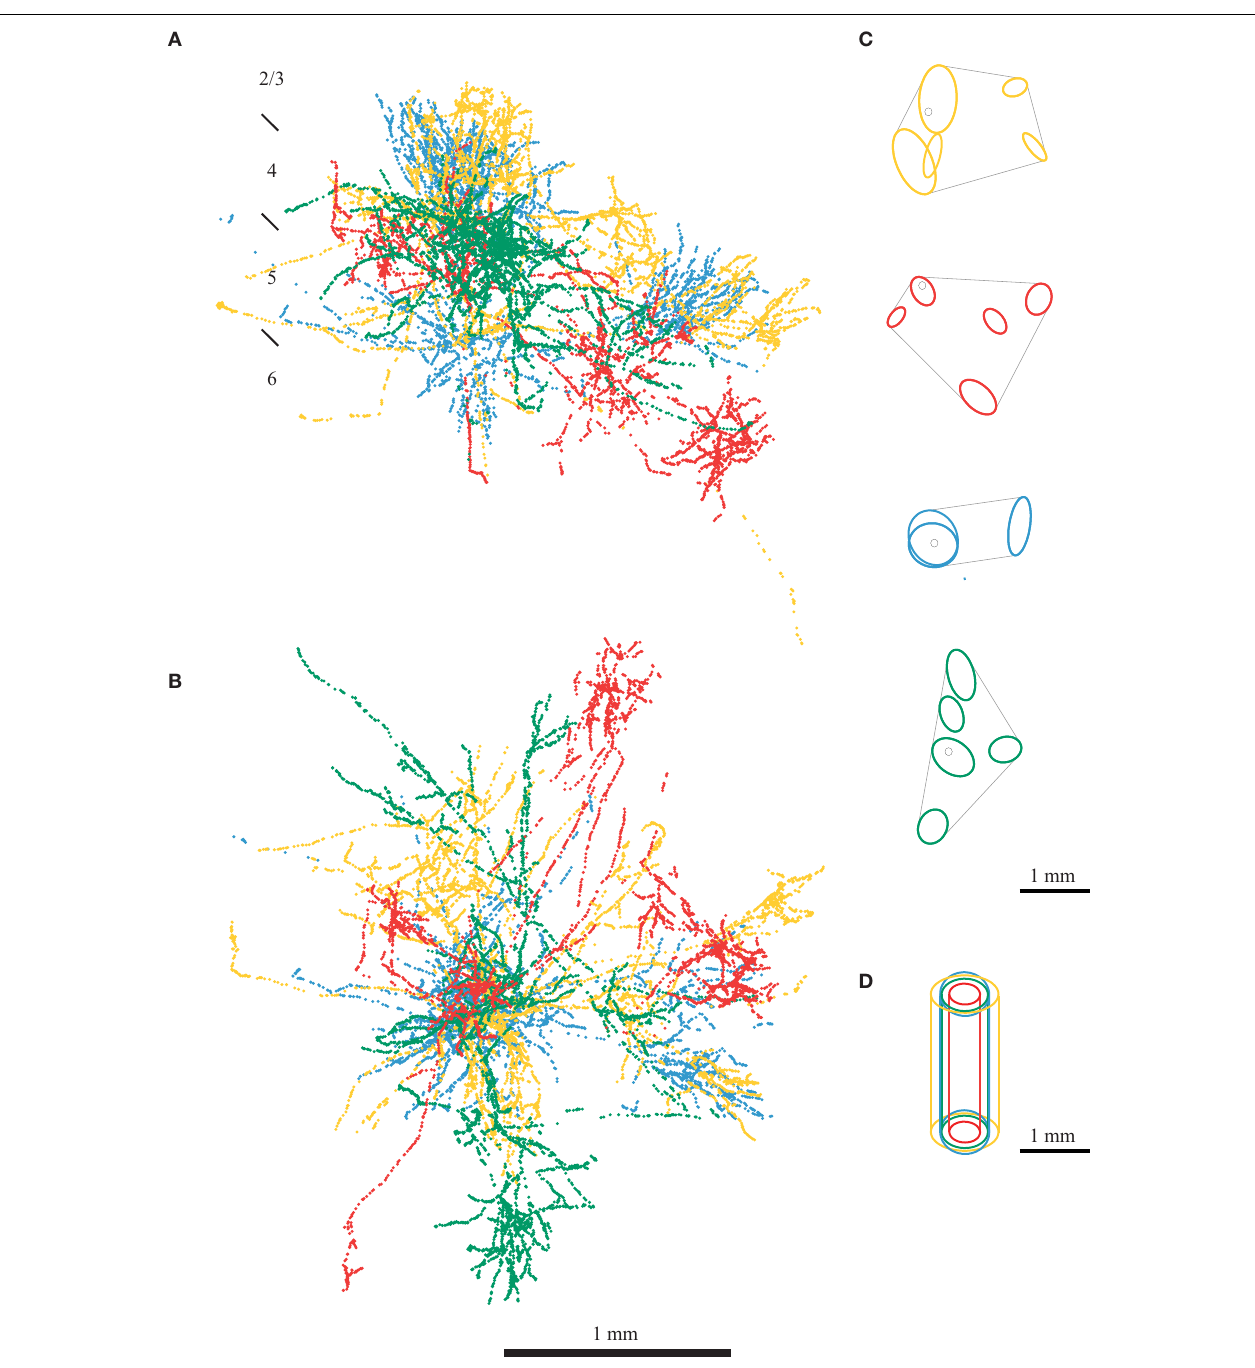
FIGURE 1 | Bouton distribution of four neurons from the primary visual cortex of cat. Axons of neurons from all layers spread over a distance covering the dimensions of many minicolumns. The boutons from a layer 2/3 pyramidal neurons are shown in yellow, from a layer 4 spiny stellate in red, from a layer 5 pyramidal neurons in blue and from a layer 6 pyramidal neuron